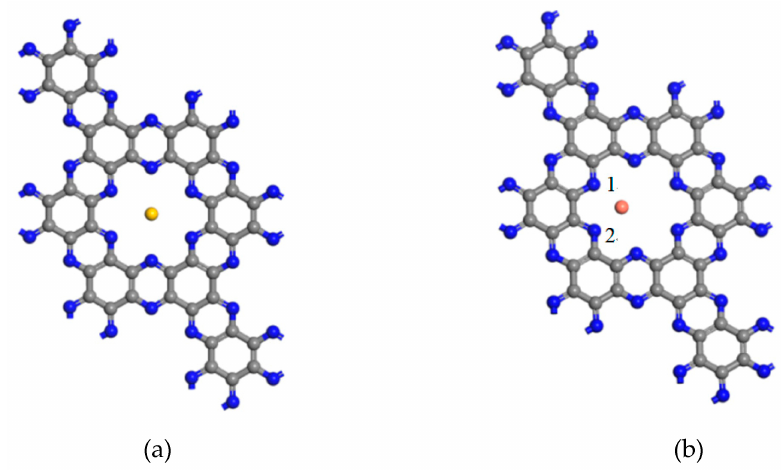
Figure 1. The optimized structures of the two catalysts: ( a ) Au/C 2 N and ( b ) Cu/C 2 N. (Blue, grey, yellow and orange balls represent N, C, Au, and Cu atoms, respectively). Number 1 and 2 in ( b ) represent the labels of the two N atoms.